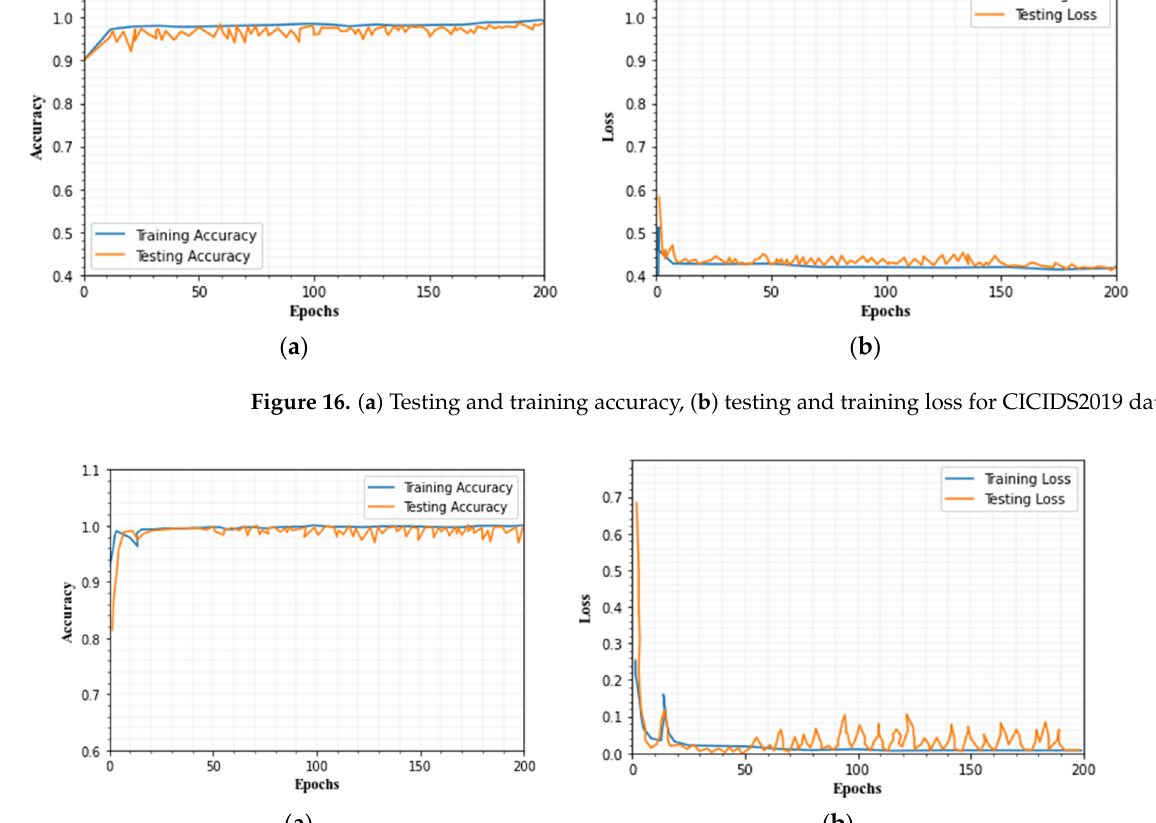
Figure 17. ( a ) Testing and training accuracy, ( b ) testing and training loss for UNSW-NB15